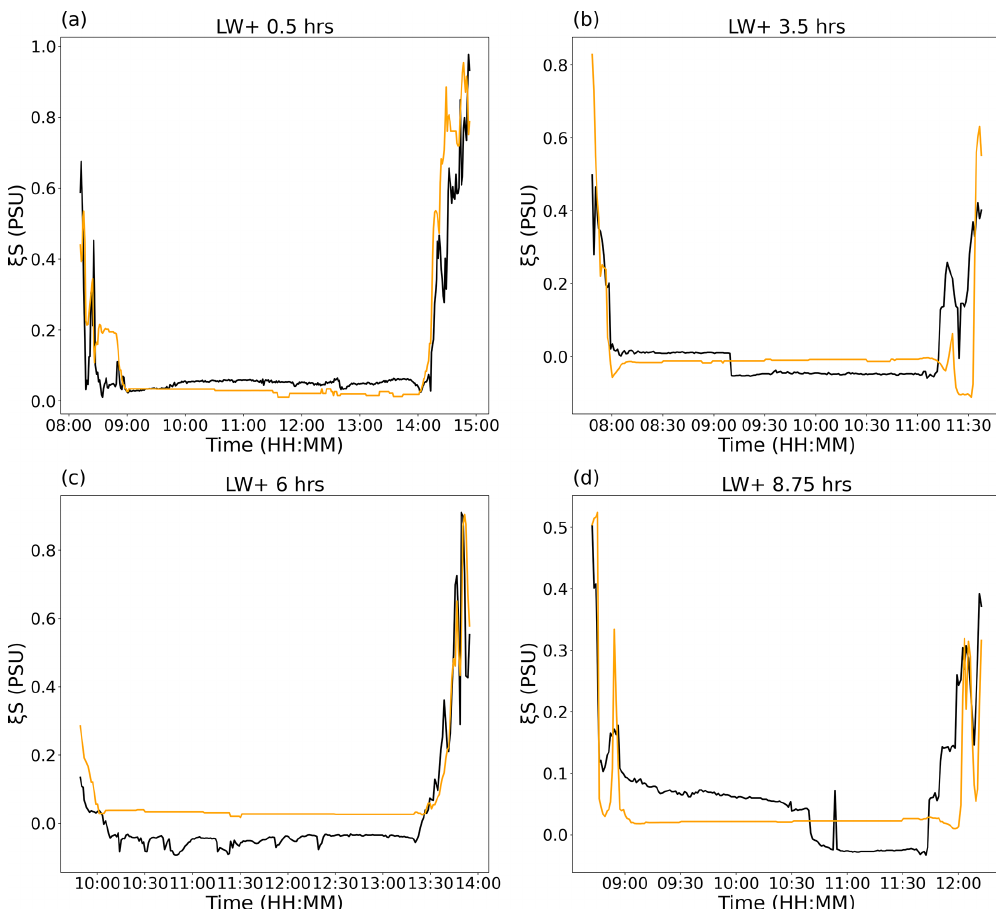
Figure 9. Comparison of ξS from surface observations (underway RV Plymouth Quest , black) and the FVCOM model (orange). Each of the four panels corresponds to the four example transects from four stages of the tidal cycle: (a) 7 July (LW + 0h), (b) 15 June (LW + 3.5h), (c) 30 June (LW + 6h) and (d) 10 June (LW +